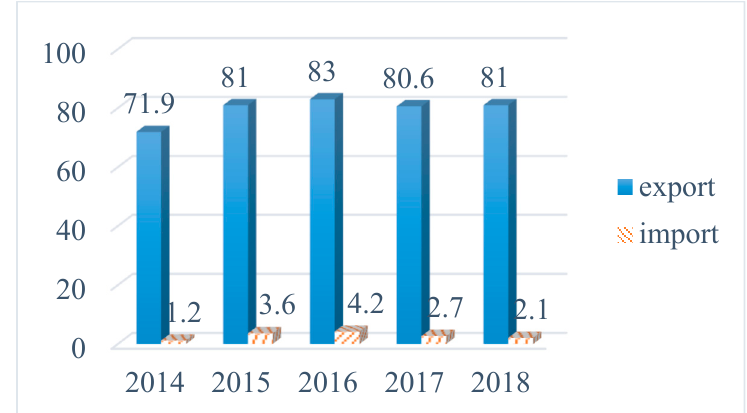
Figure 7. Live bovine animal trade (in thousands of tons) [27].